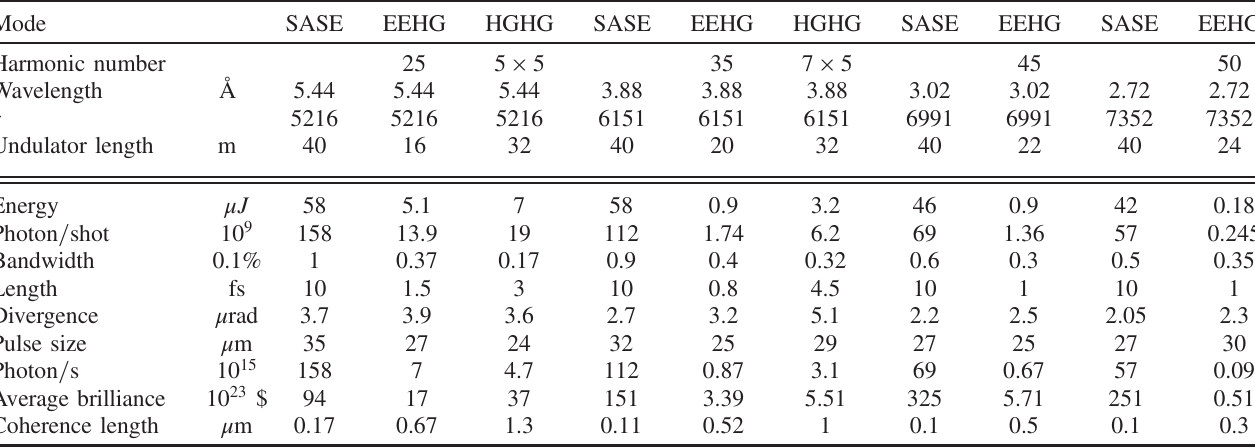
TABLE III. SASE (extracted at saturation), EEHG (extracted at minimum bandwidth) and fresh-bunch HGHG cascaded FEL characteristics, $ ¼ Photons = s = mm 2 = mrad 2 = bw ð ‰ Þ